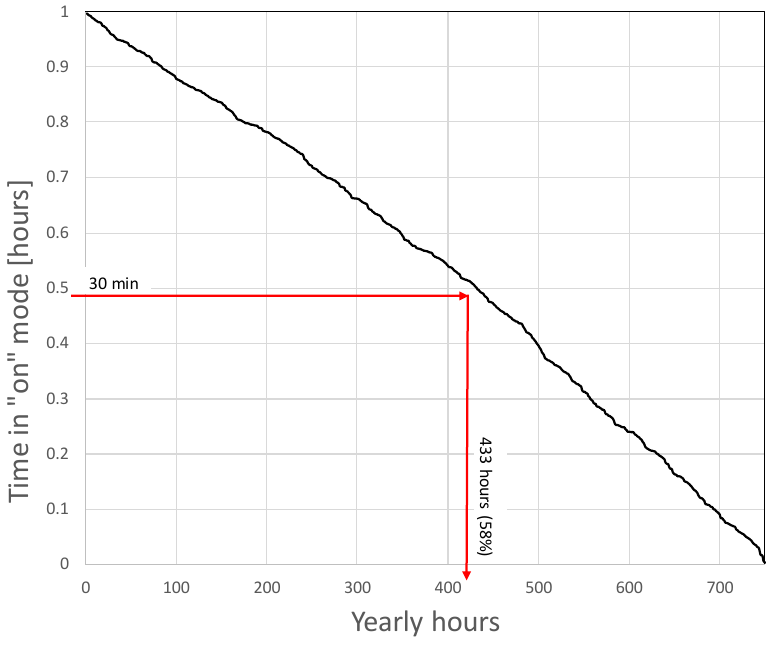
Figure 11. Hour fraction (time in hours) when the heat pump was “on”, while working in on / o ff mode. Table 9. Levelised costs in the baseline case for heat pump, de-centralised, and centralised boilers.